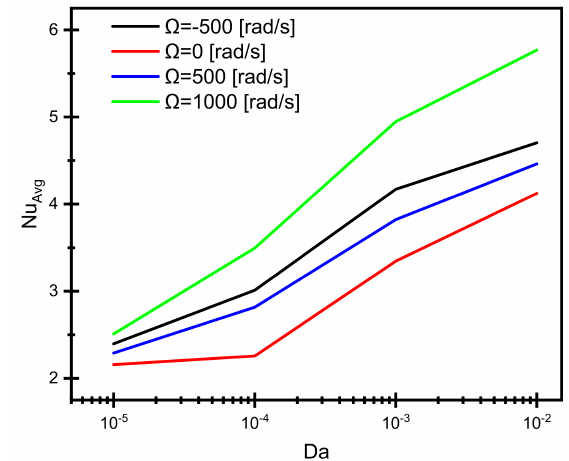
Figure 9. Effect of the Darcy number on the average Nusselt number at different values and directions of the cylinder rotation.